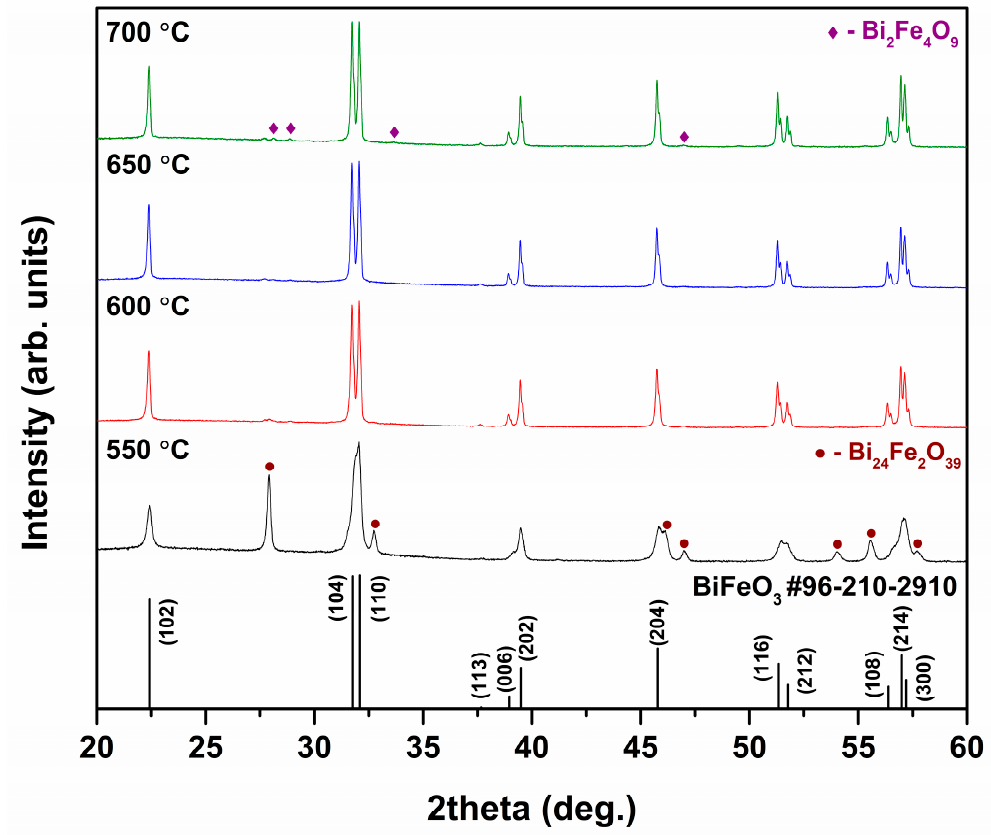
Figure 2. XRD patterns of BFO powders annealed at different temperatures.